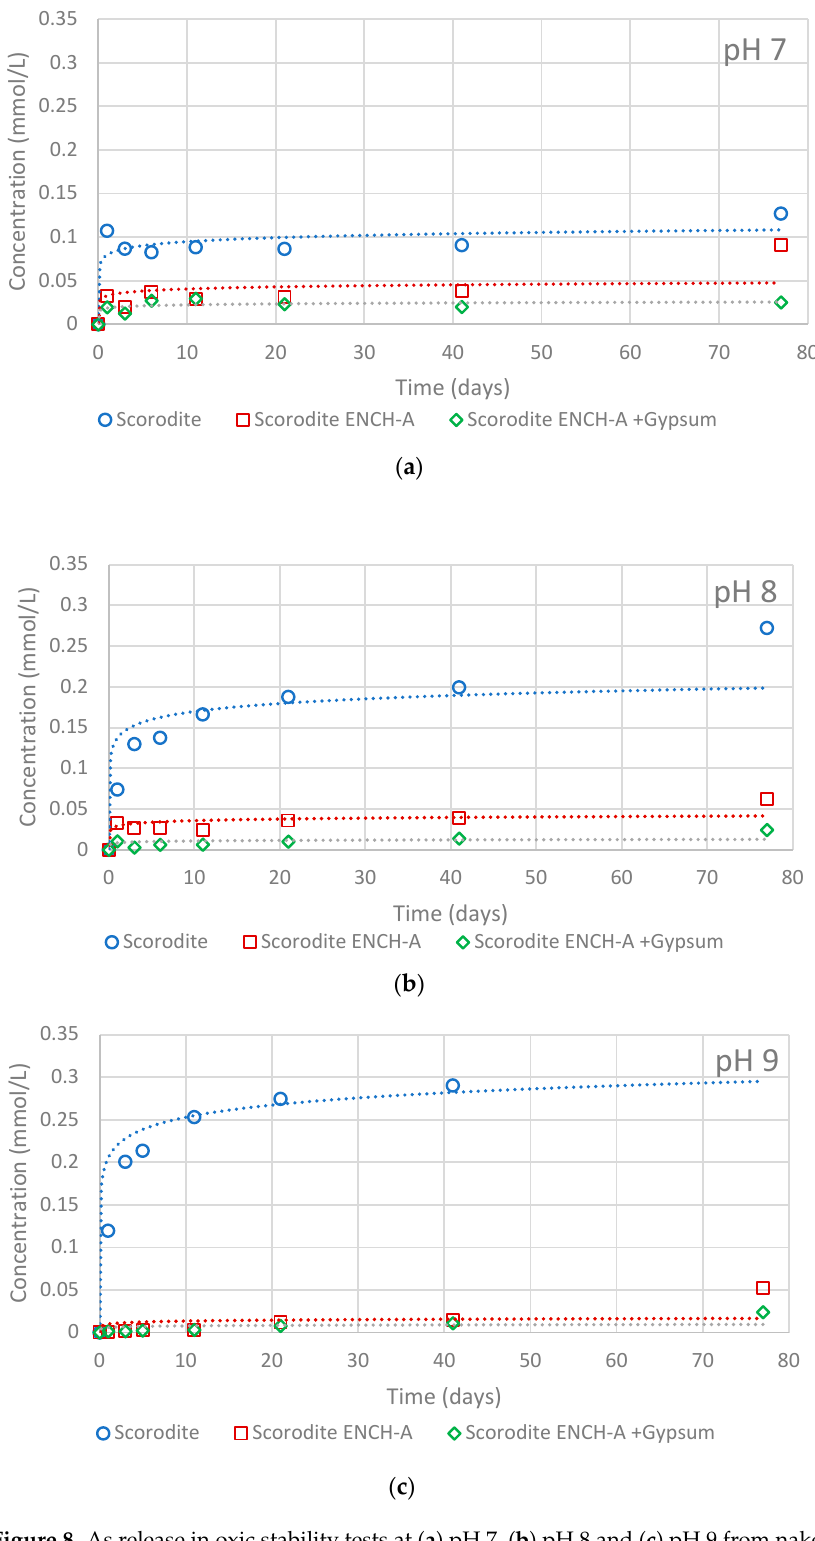
Figure 8. As release in oxic stability tests at ( a ) pH 7, ( b ) pH 8 and ( c ) pH 9 from naked scorodite and scorodite coated with HAP according to encapsulation method A in gypsum-free (ENCH-A) and gypsum-saturated water (ENCH A+Gypsum) at 22 °C.